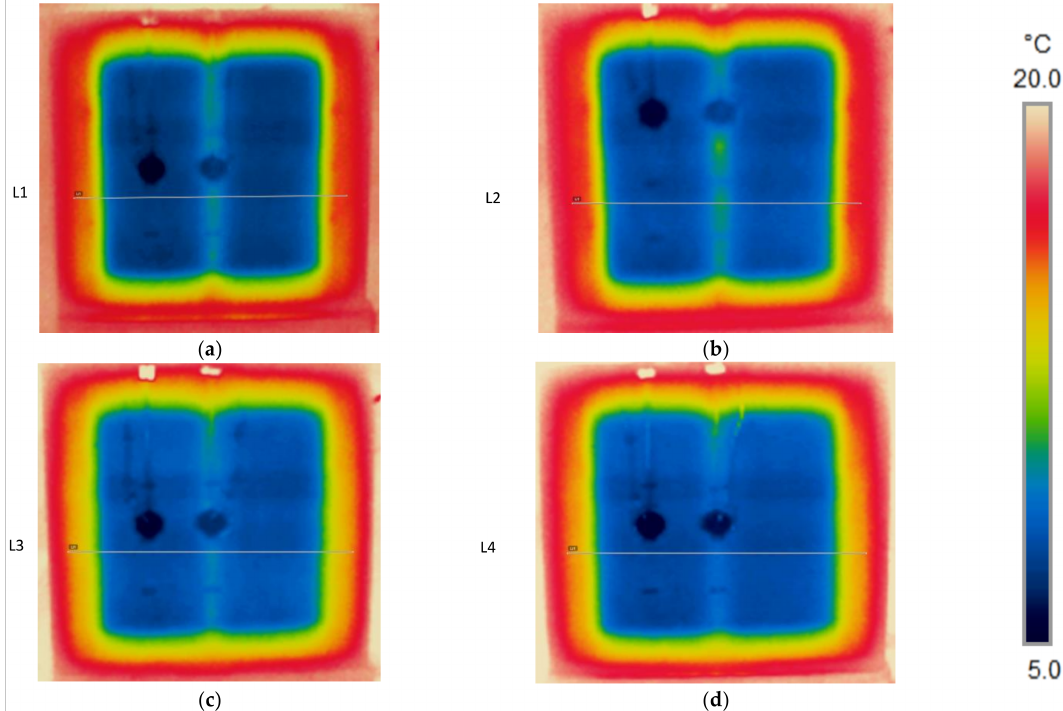
Figure 7. Infrared images of the double pane LSF walls, with and without reflective aluminium foil, for two air cavity’s thicknesses (0 and 50 mm), on the cold surface. ( a ) 0 mm without reflective foil; ( b ) 0 mm with reflective foil; ( c ) 50 mm without reflective foil; ( d ) 50 mm with reflective